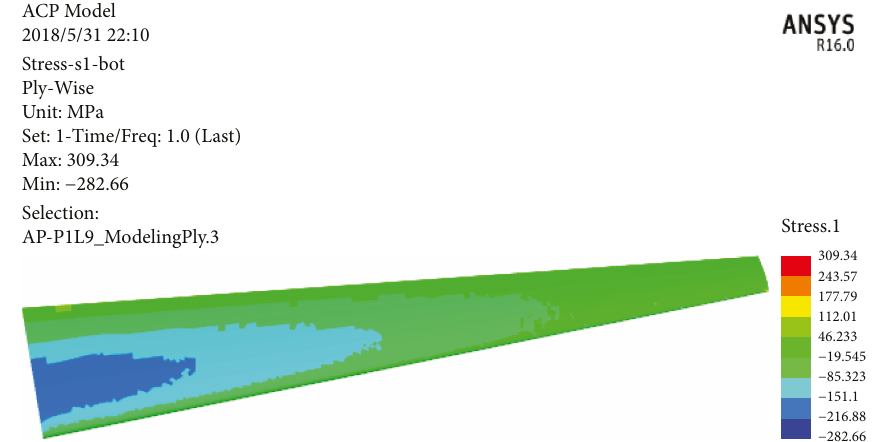
Figure 62: Stress cloud diagram of the upper wing with full composite.